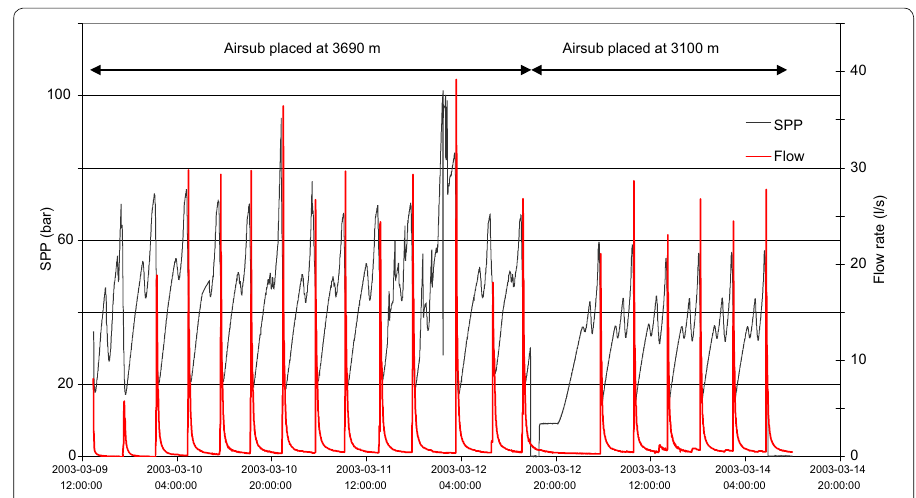
Fig. 9 Measured stand pipe pressure (SPP) and flow rate during the airlift operation conducted in the crystalline basement. Initially, the air‑sub was placed at 3690 m and later moved to 3100 m (Modified from Rosberg